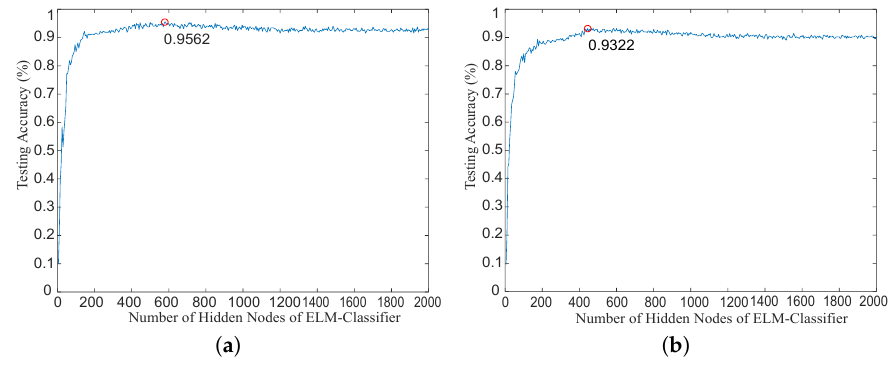
Figure 7. Testing accuracy in l subspace for the multi-layered ELM when L = 800. ( a ) Testing accuracy of single-fault; ( b ) Testing accuracy of